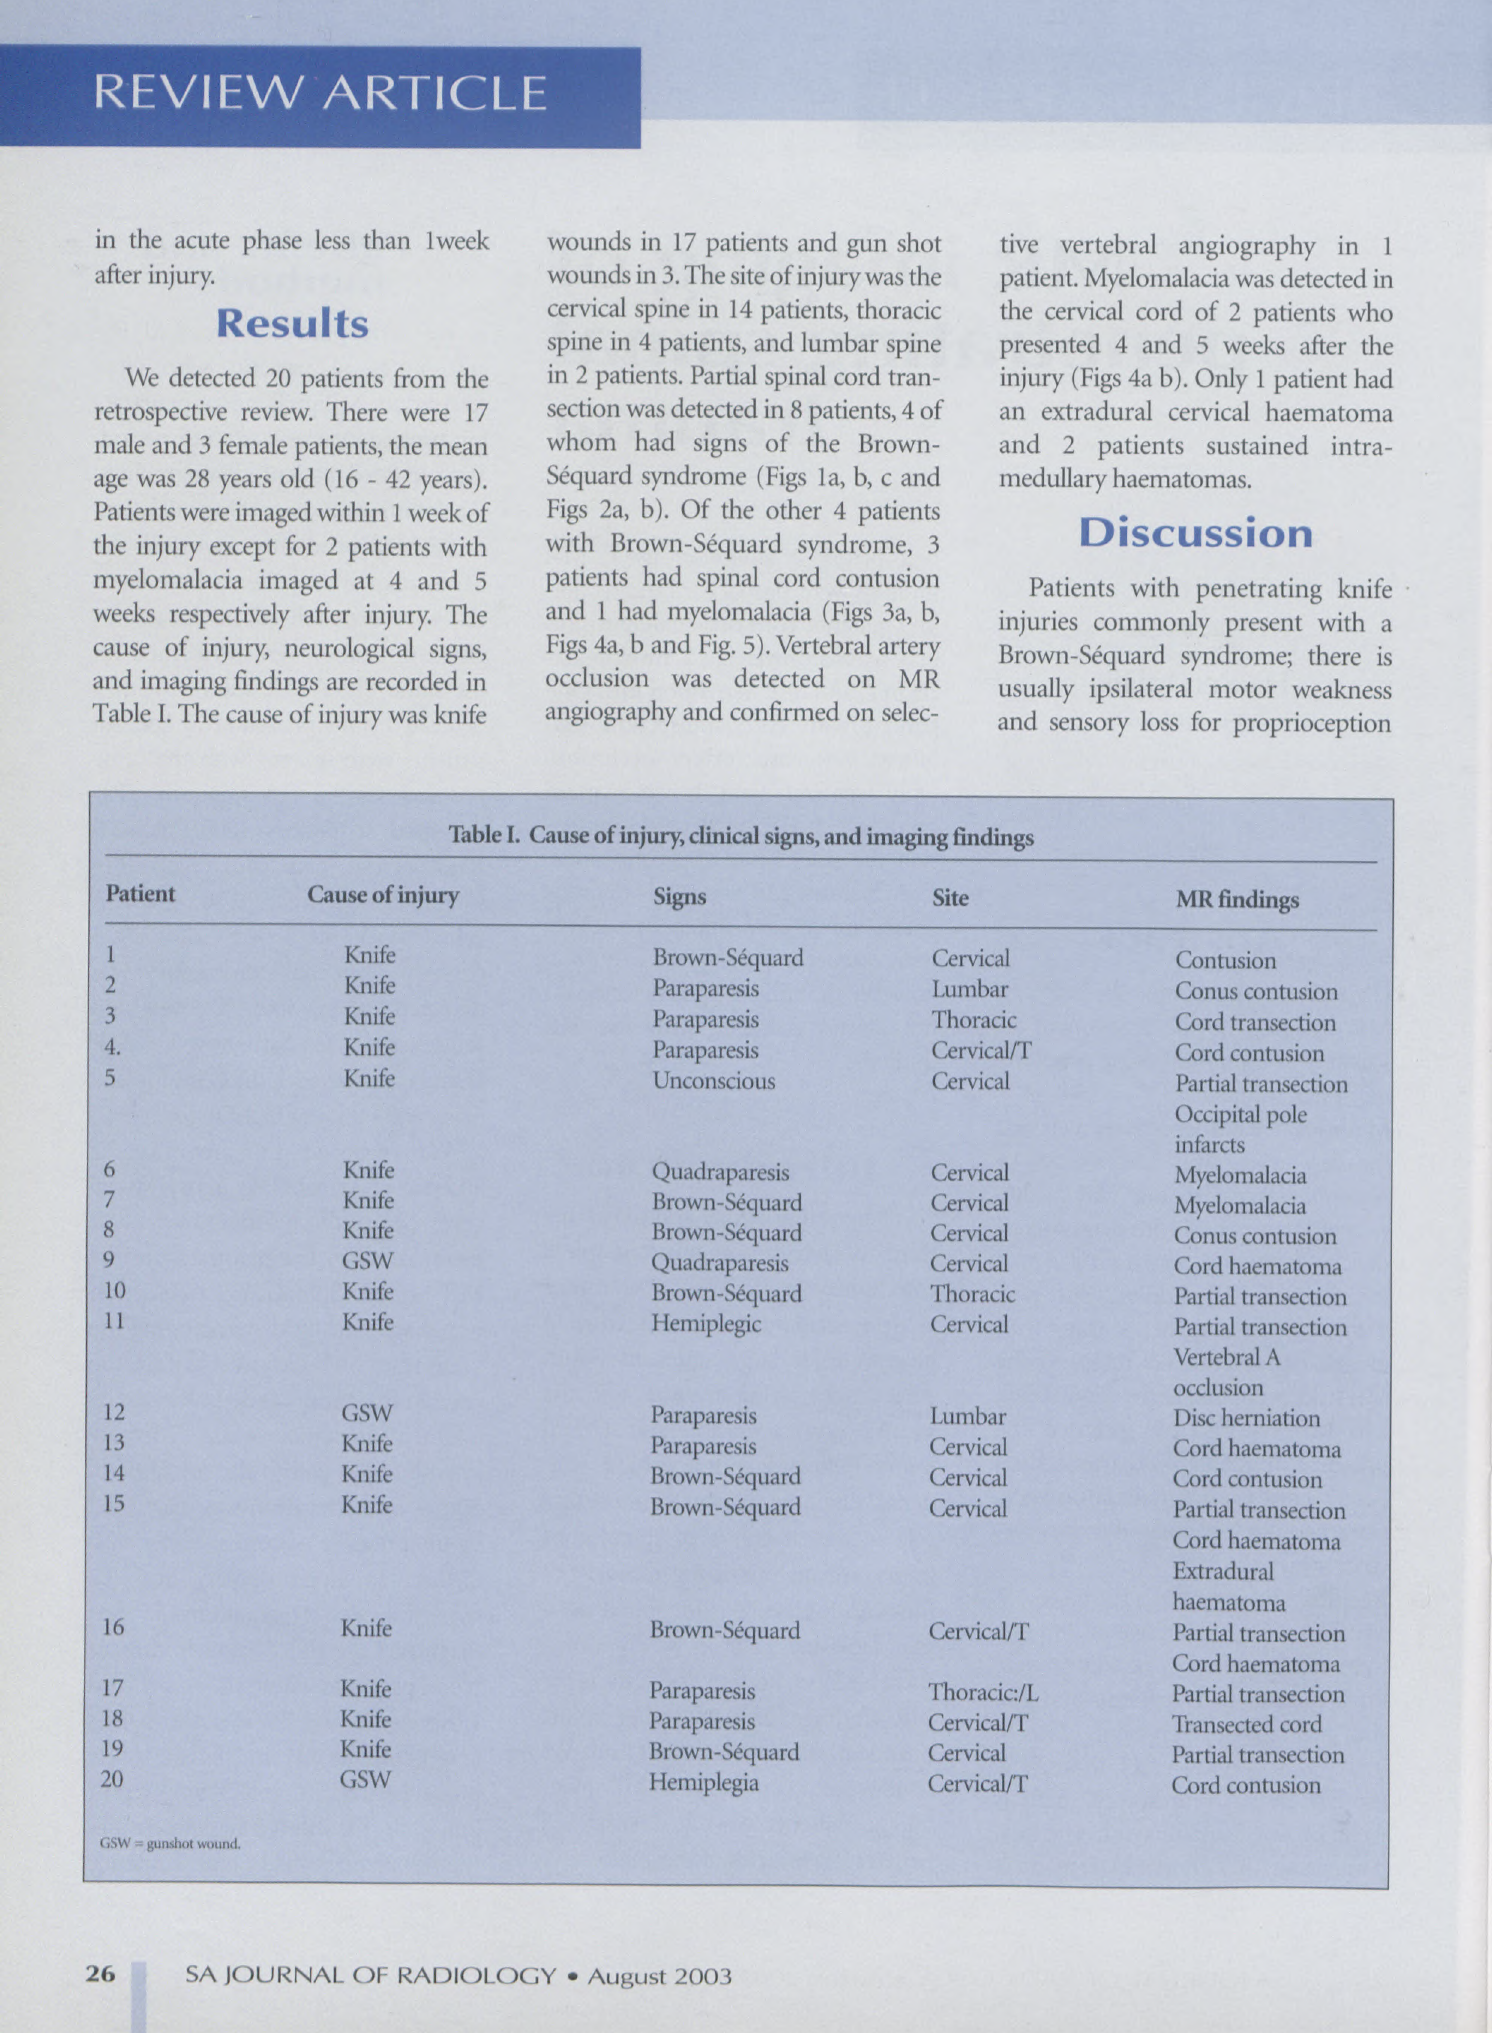
Table I. Cause of injury, clinical signs, and imaging